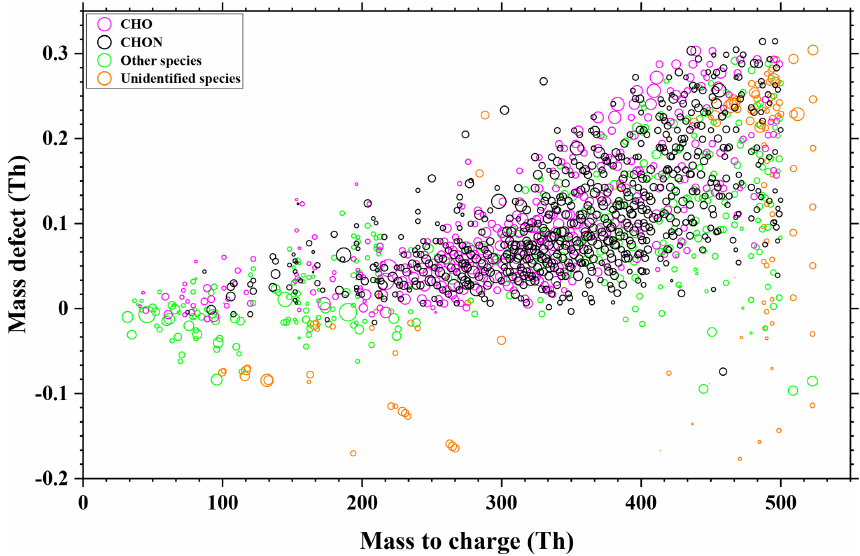
Figure 2. A typical mass defect plot for compounds desorbed from a filter collected during 07:00–07:15, 15 January 2019, in Wangdu. The symbol size is proportional to the logarithm of signal intensity. The reagent ion (I − ) was not removed from their